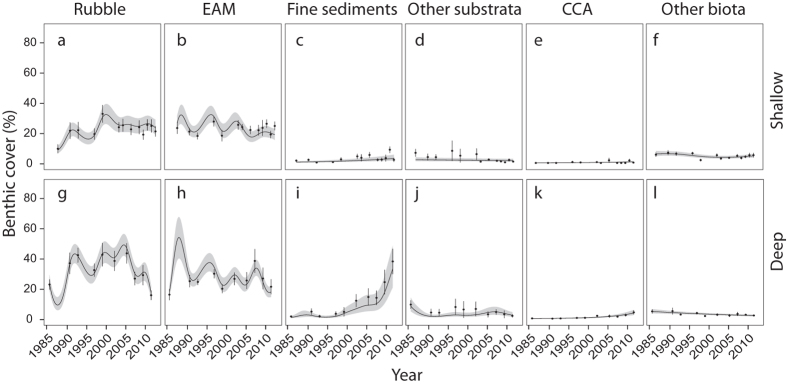
Changes in mean % cover (±SE, n = 6–10) of rubble (a,g), EAM (b,h), fine sediments (c,i), other substrata (d,j), CCA (e,k) and other biota (f,l) at shallow (a–f) and deep sites (g–l). The fitted line is the predicted covers based on the binomial GAMM model (see Methods), shaded areas are confidence intervals.